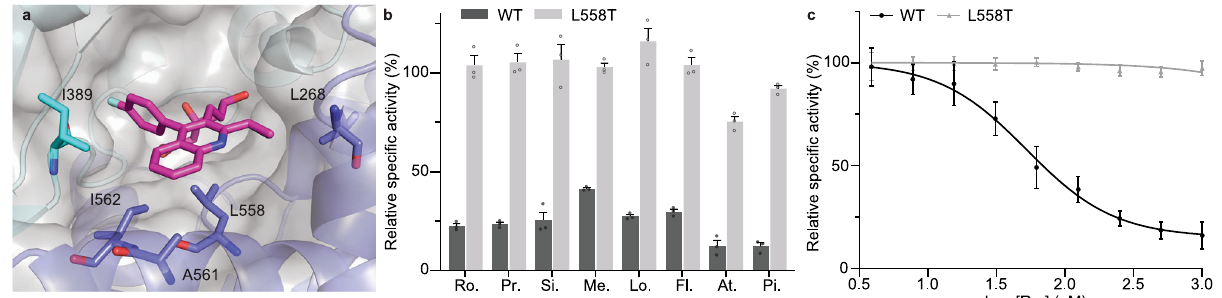
mevastatin(Me.),lovastatin(Lo.), fl uvastatin(Fl.),atorvastatin(At.)andpitavastatin (Pi.), at 500nM. n =3 independent reactions with the mean±s.d. c In vitro inhibi- tion ofWT (black plot) and L558TAtHMG1 (greyplot) byrosuvastatin revealed the L558T mutation conferred >20-fold resistance. n =3 independent reactions with the mean±s.d. Source data are provided as a Source Data fi le.